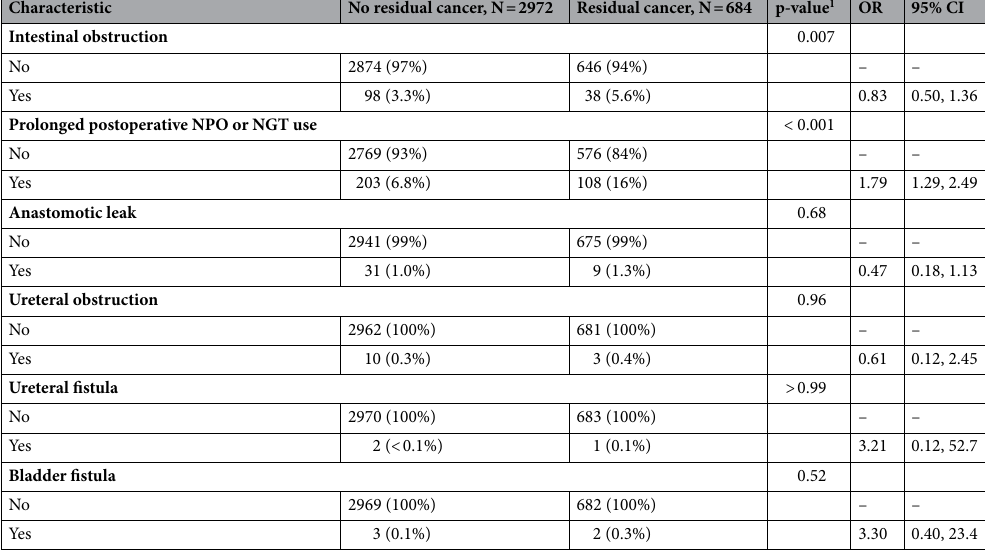
Table 3. Clinical complication outcome variables summary table. OR odds ratio, CI confidence interval. 1 Continuous Variable: one-way ANOVA, Binary Variable: Fisher’s Exact Test, Categorical Variable: Chi- Squared Test.